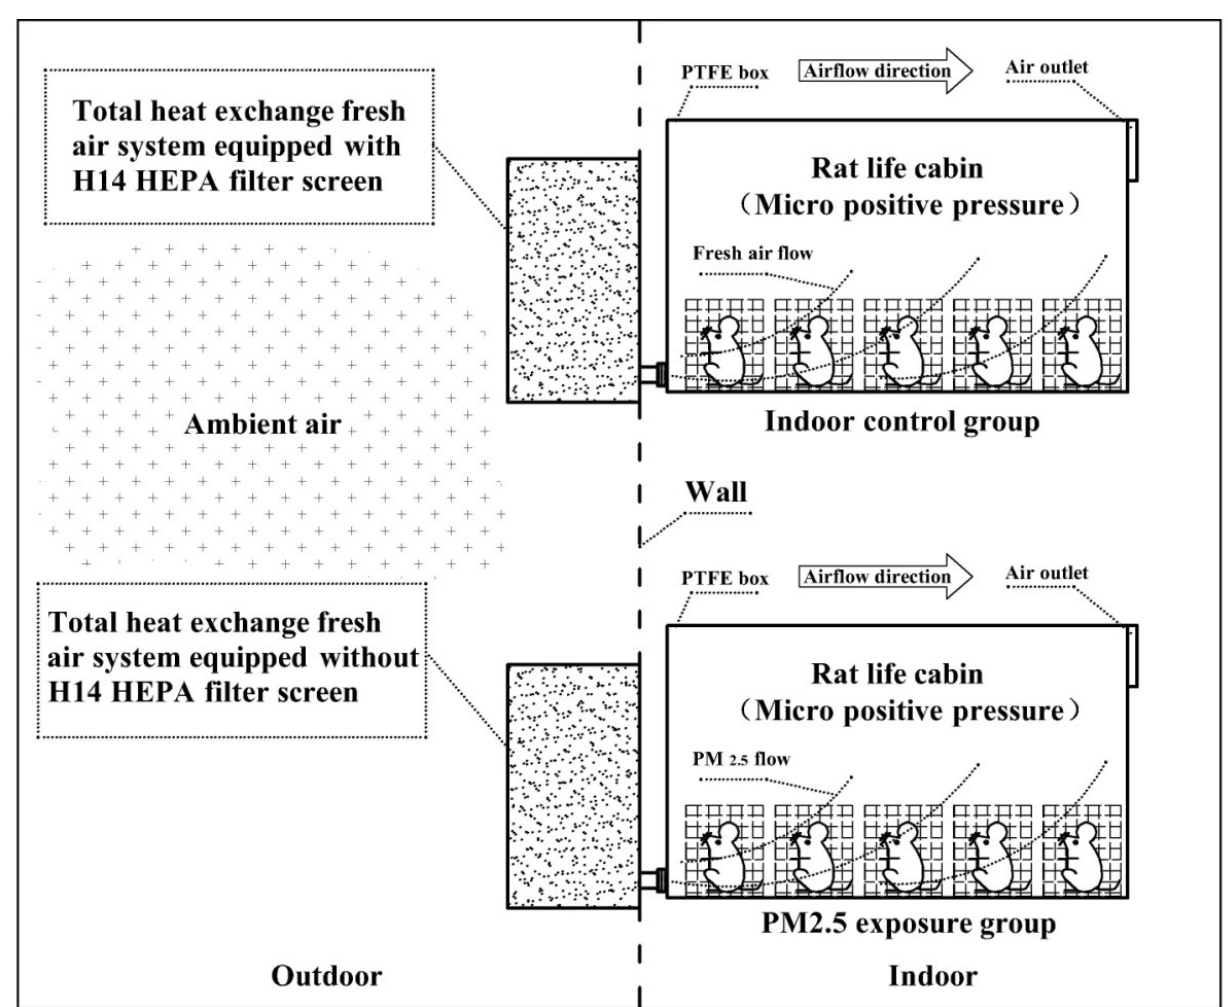
Figure 1. The diagrammatic sketch of the experiments. Control group: Ambient air was filtered through the HEPA filter screen with a removal rate of PM 2.5 higher than 99% and flowed into an indoor room where the living chambers of mice were located ( n =5). Exposure group: Ambient air was filtered through the impact cutter of PM 2.5 and flowed into an indoor room where the living chambers of mice were located ( n =5). PTFE, Polytetrafluoroethylene.